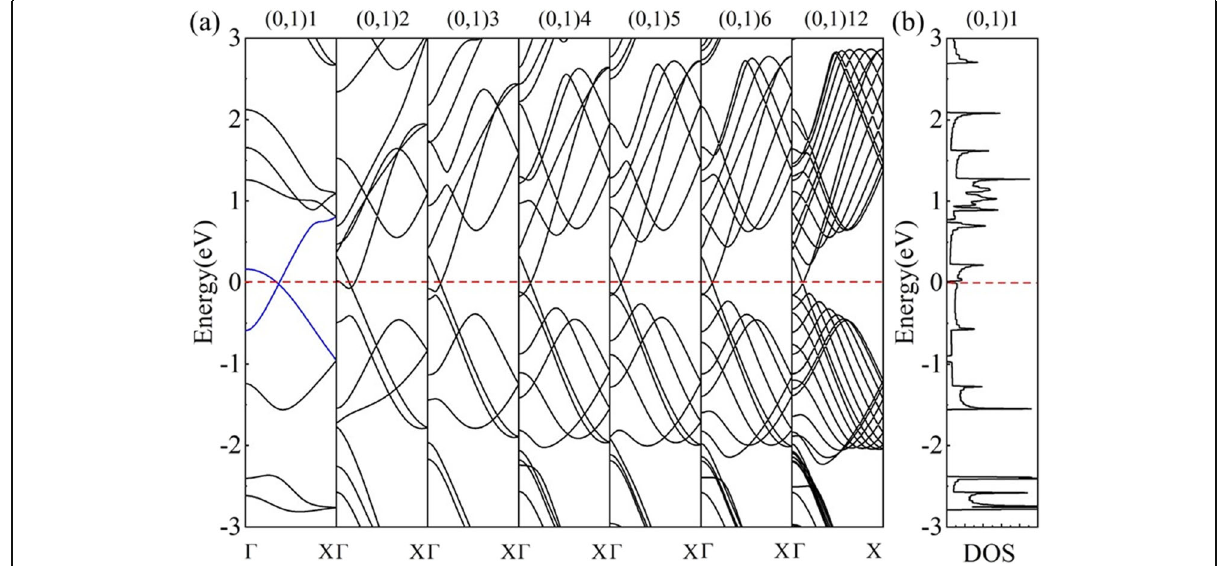
Fig. 6 ( a ) Band evolution of (0,1) n nanotubes ( n = 1, 2, 3, 4, 5, 6, 12); ( b ) DOS of the (0,1)1